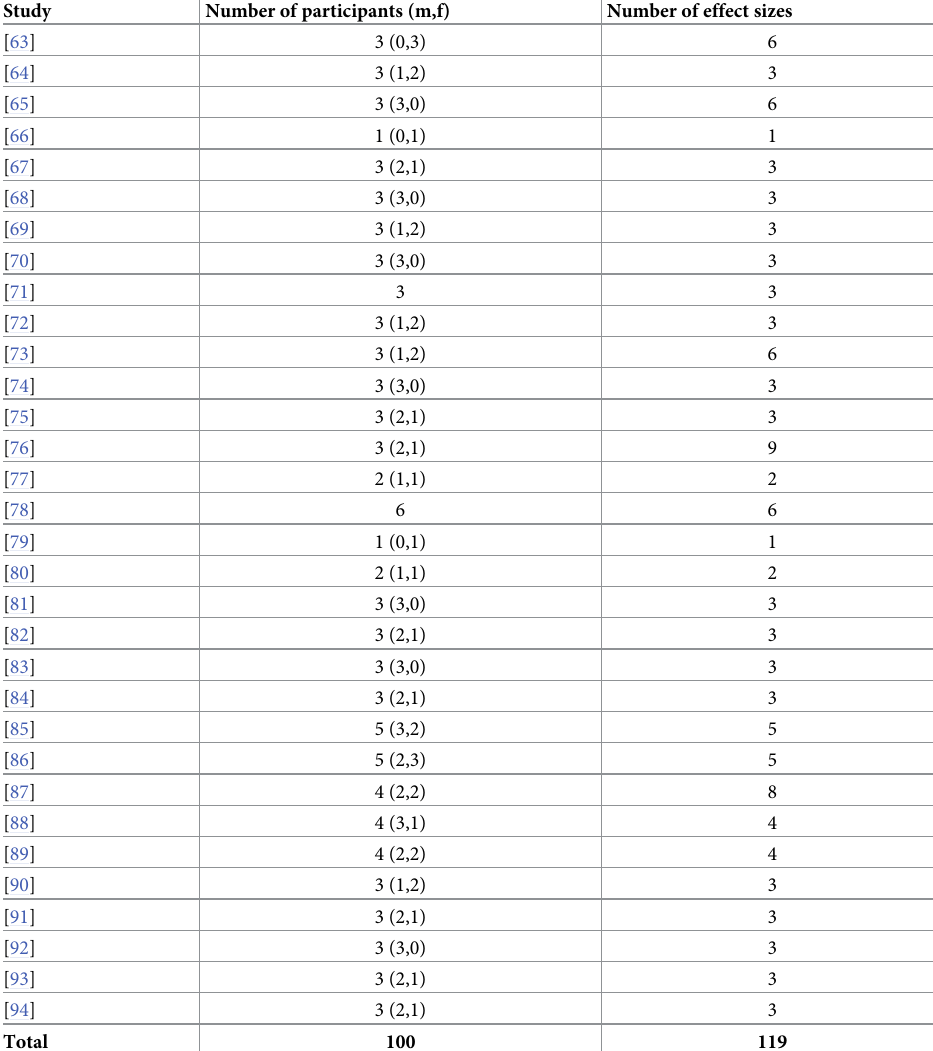
Table 2. Number of participants and effect